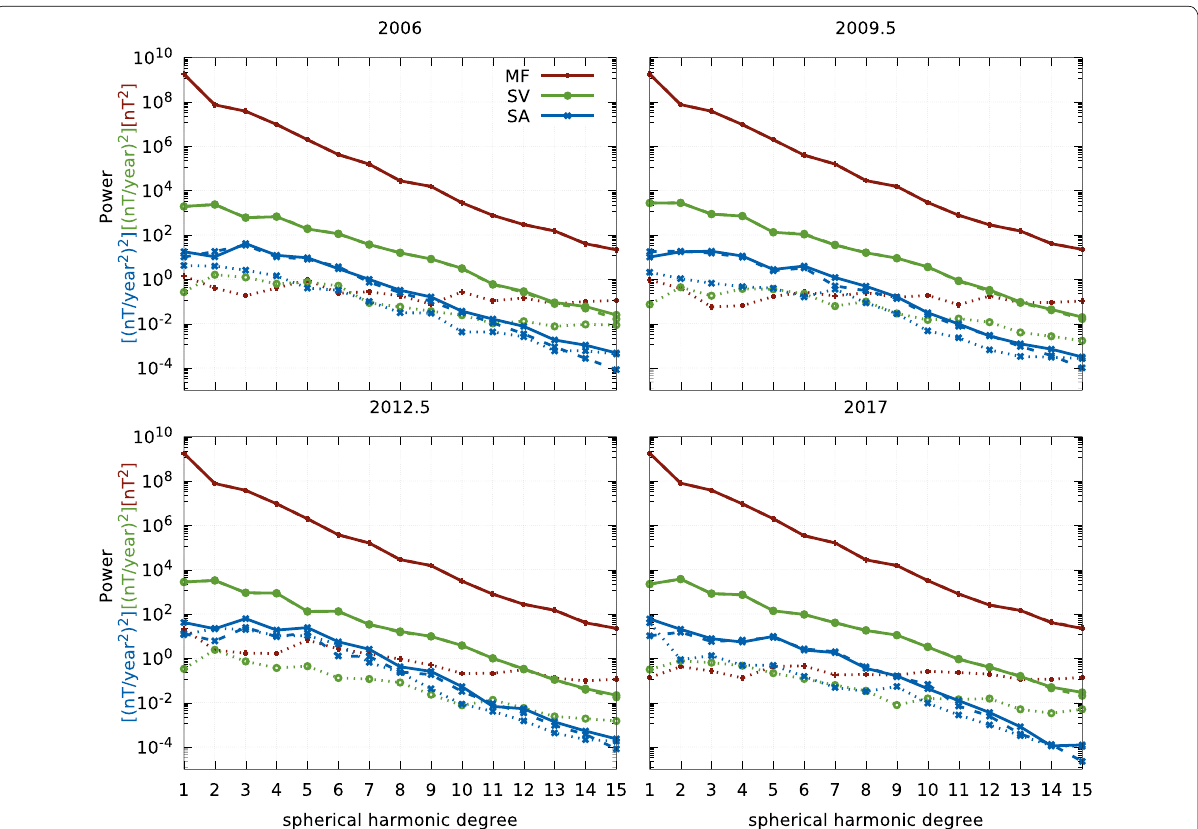
Fig. 9 Lowes–Mauersberger power spectra at Earth’s surface at four different epochs for the main field (red), secular variation (green), and secular acceleration (blue). Model A is represented by solid lines, CHAOS-6-x9 by dashed lines, and the difference between the two by dotted